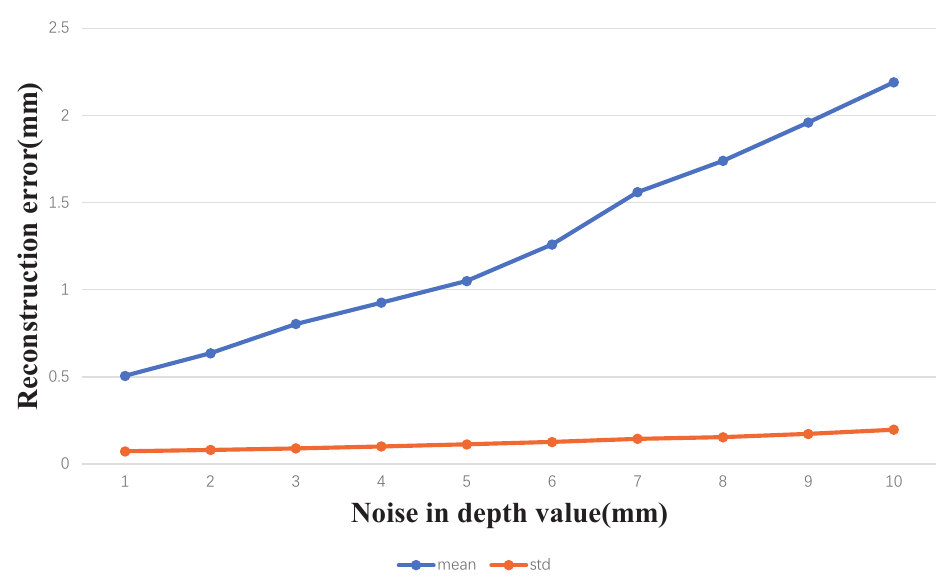
Figure 5. Reconstruction accuracy of our method on synthetic data with different noise